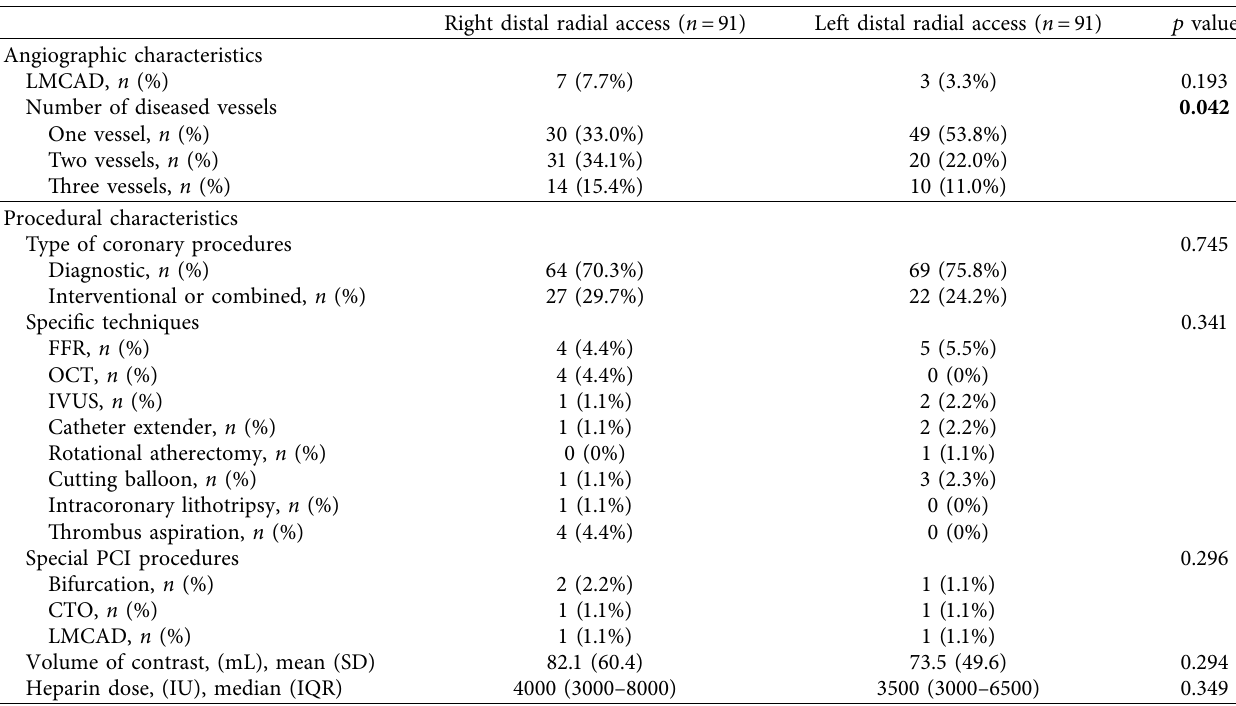
Table 3: Angiographic and procedural characteristics.